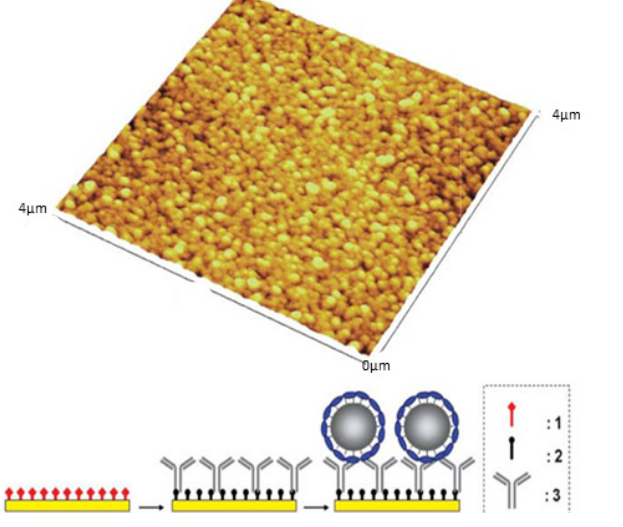
Figure 42. Non-contact mode AFM of proteo-SLNs immobilized on a gold surface via antibody-antigen interactions and schematic representation of the strategy used to attach the SLNs on the surface ( 1 : activated ester; 2 : deactivated amide functions, 3 : antibody anti-BSA)